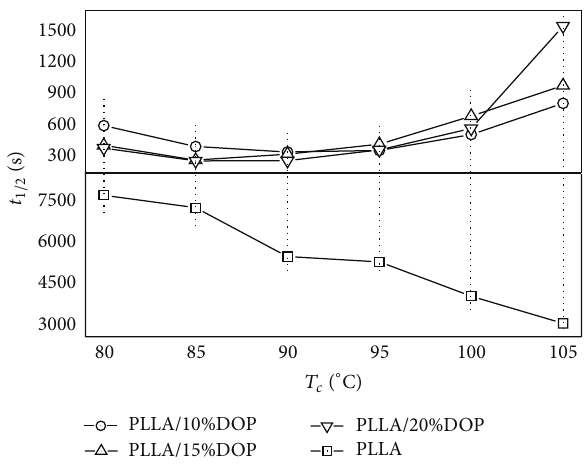
Figure 1: The 𝑡 1/2 of PLLA and PLLA/DOP with the crystallization temperature 𝑇 𝑐